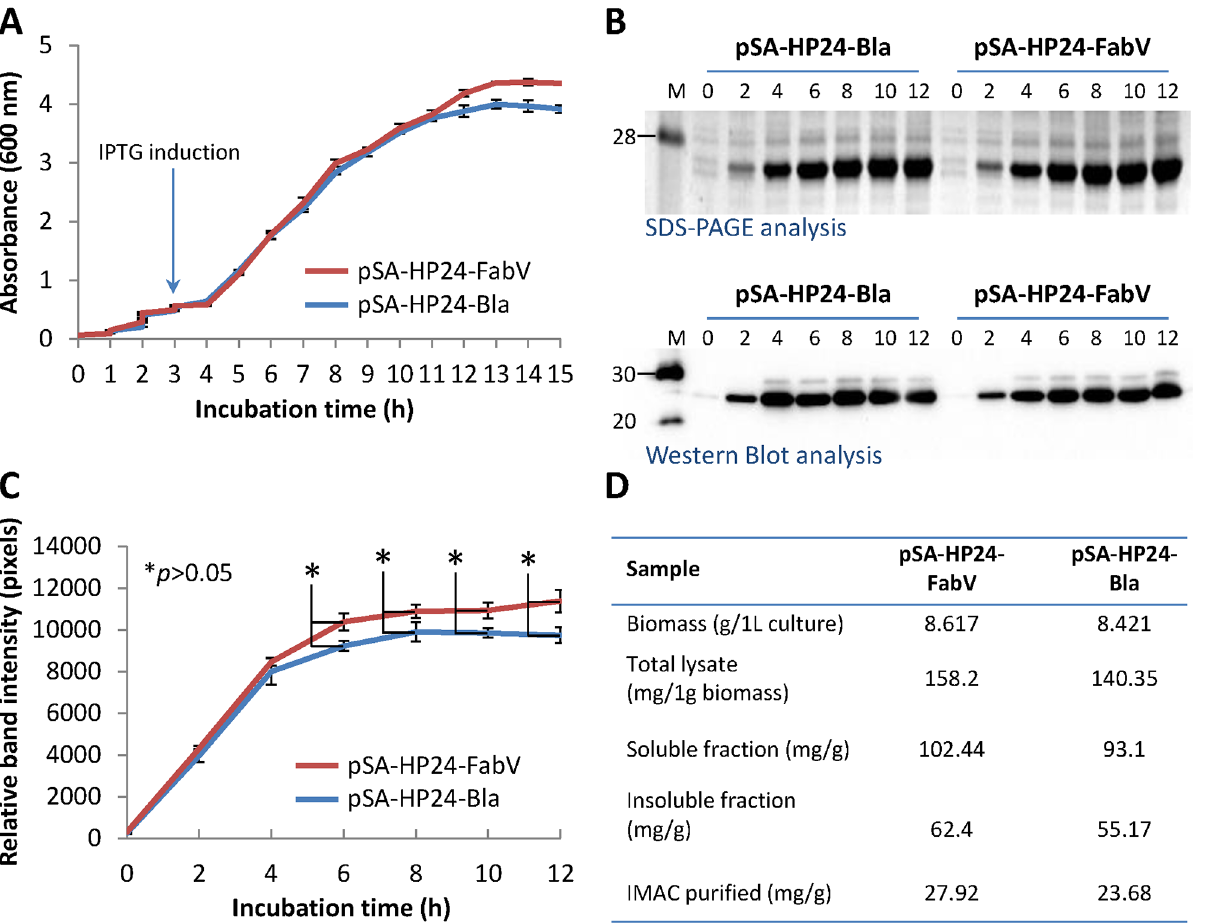
Fig 3. Culture growth, protein expression kinetics, and recombinant protein yields. BL21(DE3) cells were transformed with pSA-HP24-Bla or pSA-HP24-FabV plasmids and cultured in LB broth supplemented with either 269 μ M (100 μ g mL -1 ) Ampicillin or 1 μ M Triclosan respectively. Protein expression was induced with 50 μ M IPTG when cultures reached to 0.5 OD600. Induced and uninduced cultures were grown at 30°C for 15 h. Culture samples were collected at 1 h interval and used to monitor bacterial growth (A). Samples collected at various times points were analysed for recombinant P24 production (B) and protein expression kinetics (C). Recombinant P24 was purified from and biomass and protein yield compared between two cultures (D). Error bars show standard deviations calculated from at-least three independent experiments each performed in